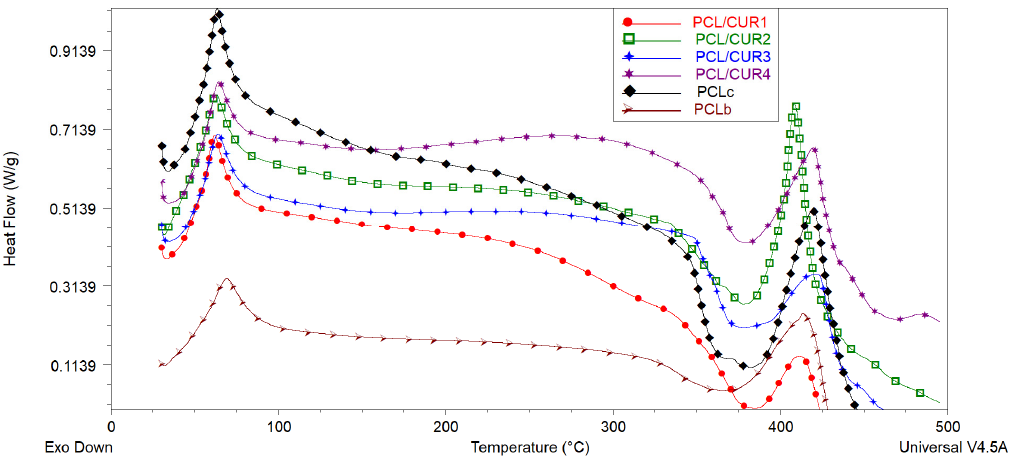
Figure 6. The DSC spectra of PCL/CUR scaffolds.